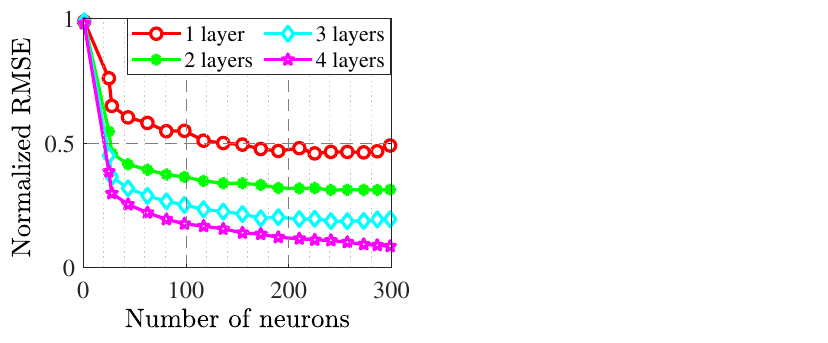
Figure 3. Sequence of achieving accurate number of hidden layers in modeling GaN HEMT